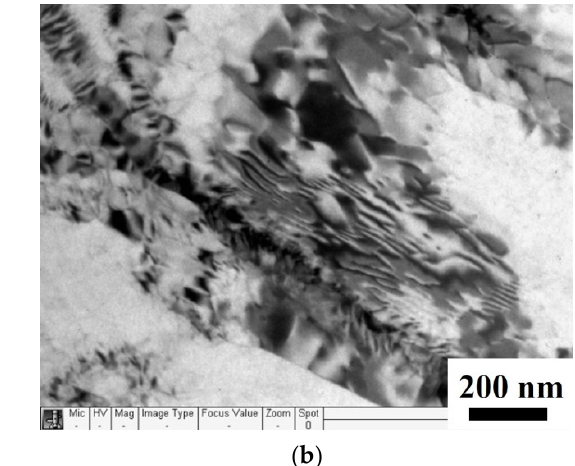
Figure 8. Microstructure of the near ‐ surface layer of a Ti ‐ 6Al ‐ 4V sample with UFG structure after PEP + II: accumulations of crystal defects along subgrain boundaries ( a ); redistribution and partial annihilation of dislocations ( b ). TEM.